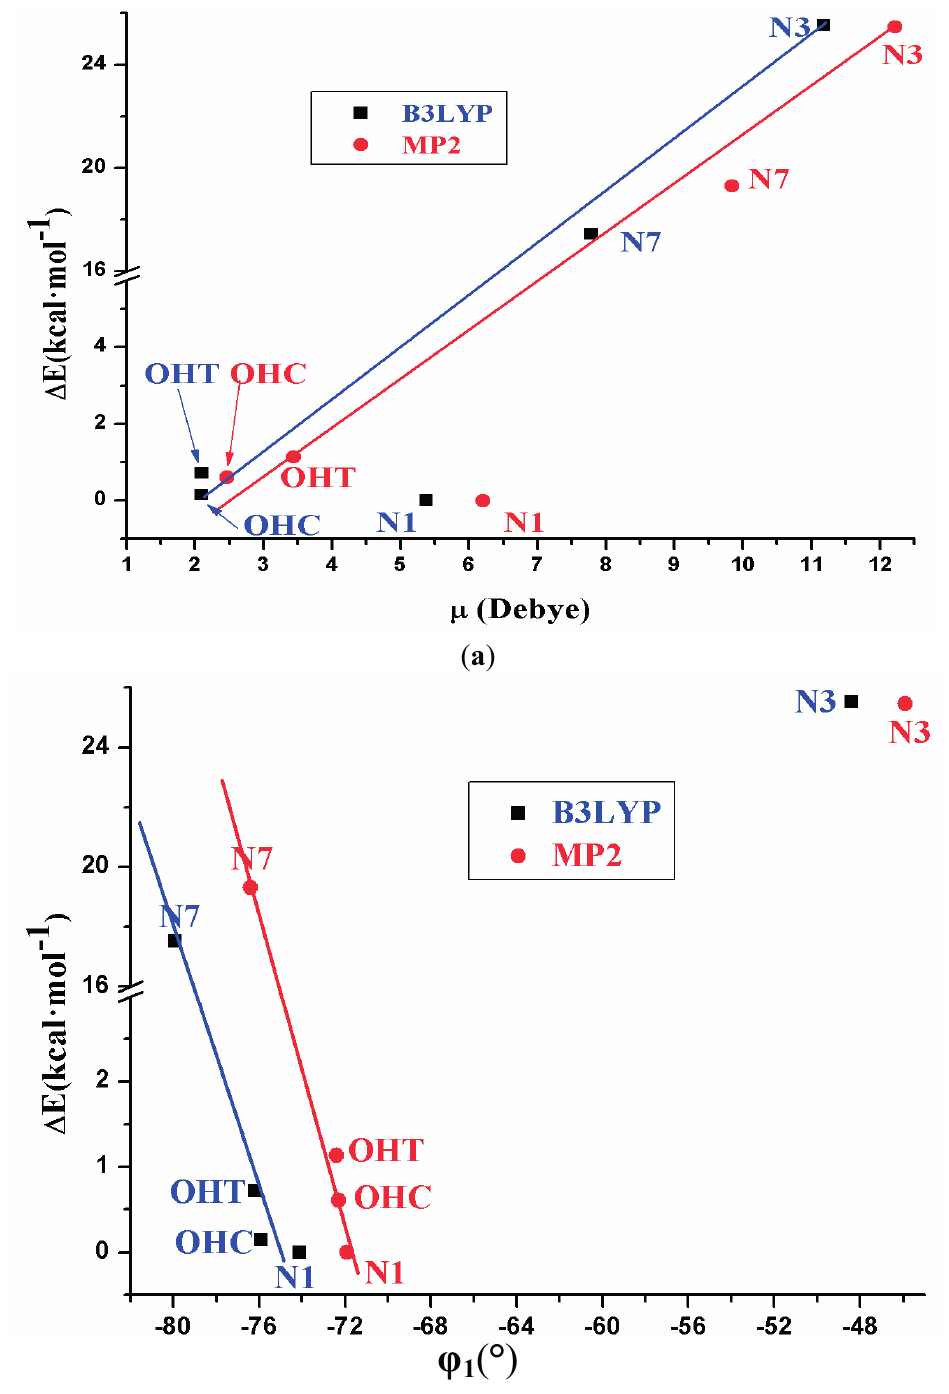
Δ E + ZPE correction of the different tautomers vs . ( a ) the dipole moment μ . and ( b ) the exocyclic torsional angle φ 1